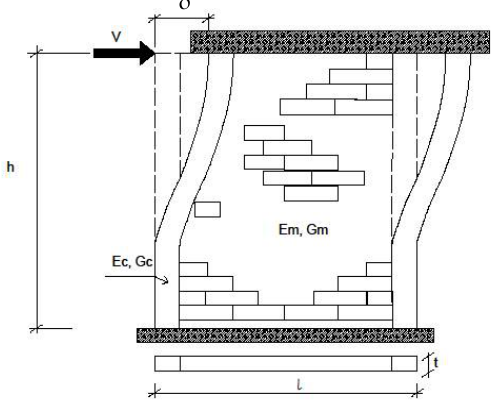
Figure 1. Deformation of unreinforced masonry wall under lateral loading.